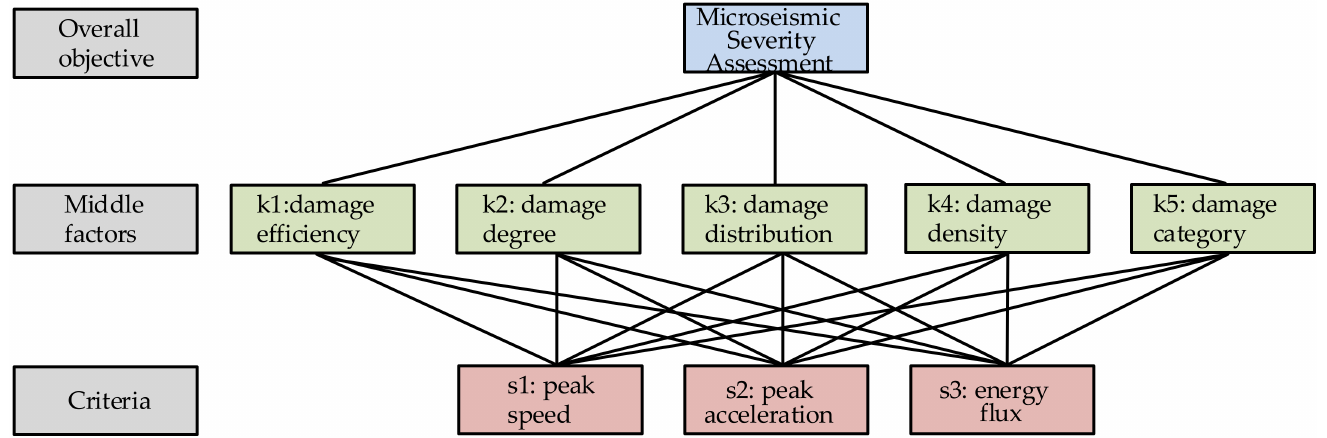
Figure 2. Theoretical framework for establishing weights by